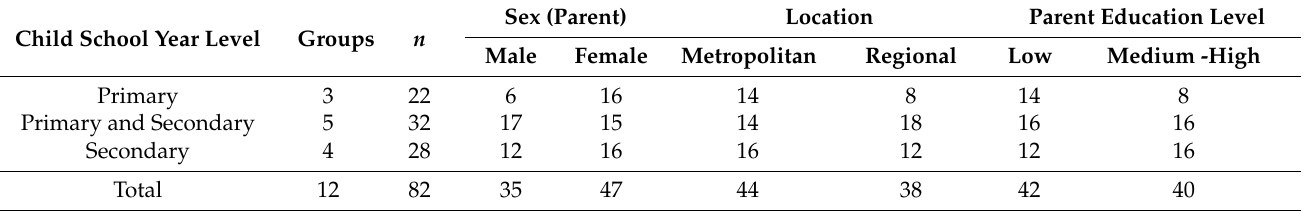
Table 2. Number of participants by location, parental sex and education level, and child school level.